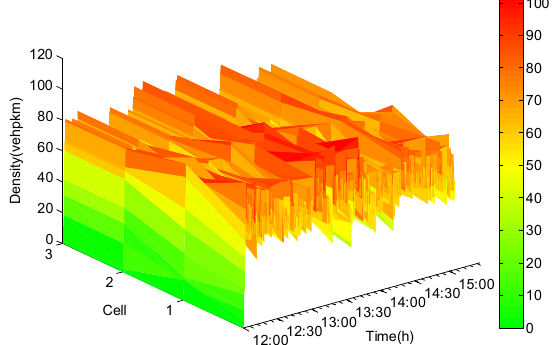
Figure 6. Estimated vehicle densities.